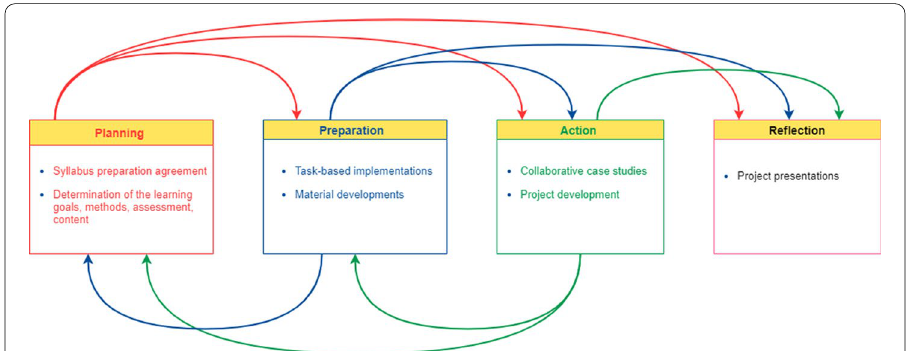
Fig. 1 Overview of the instructional technologies course